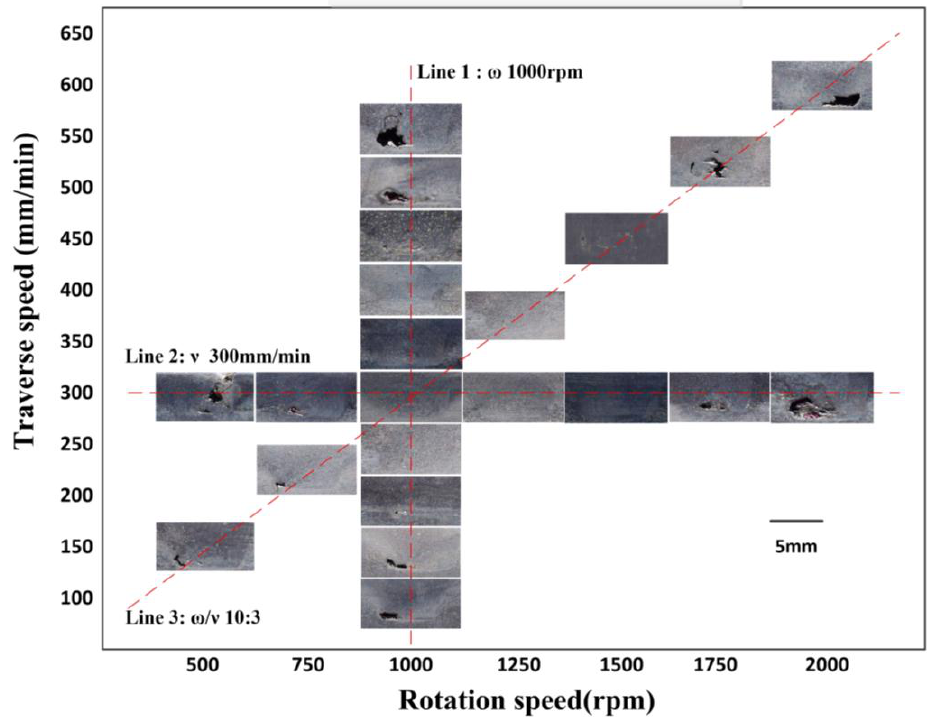
Figure 4. The stirred zone cross sections of one-pass FSLW components under diverse process parameters.